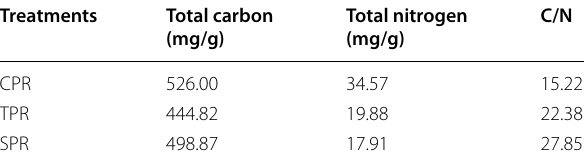
Table 1 Basic characteristics of examined vegetable residues Treatments Total carbon